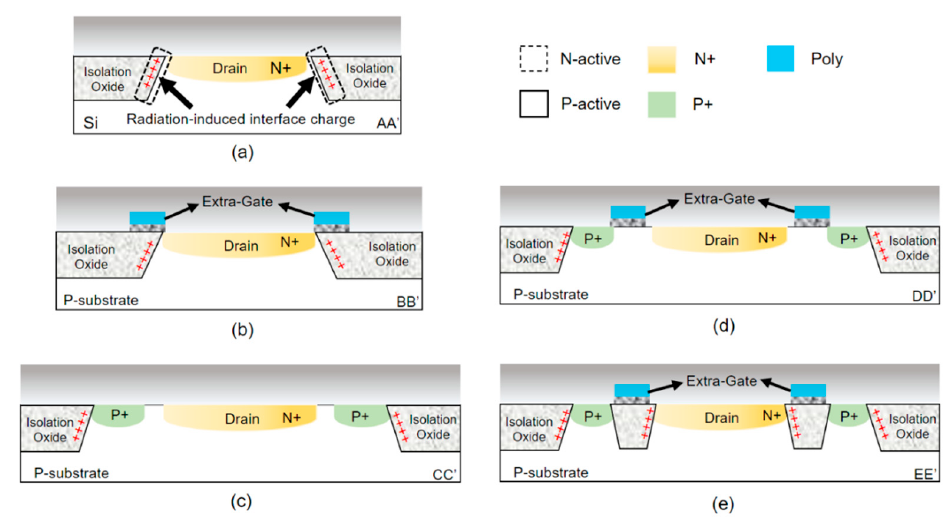
Figure 3. Cross-sectional views of the pattern-specific n-MOSFETs: ( a ) the standard structure; ( b ) the extended gate poly structure; ( c ) the structure to which the p-active and p+ doping regions are added; ( d ) the combined structure of ( b , c ); and ( e ) the same structure as ( d ) except that the n-active region is not overlapped with the p-active region.